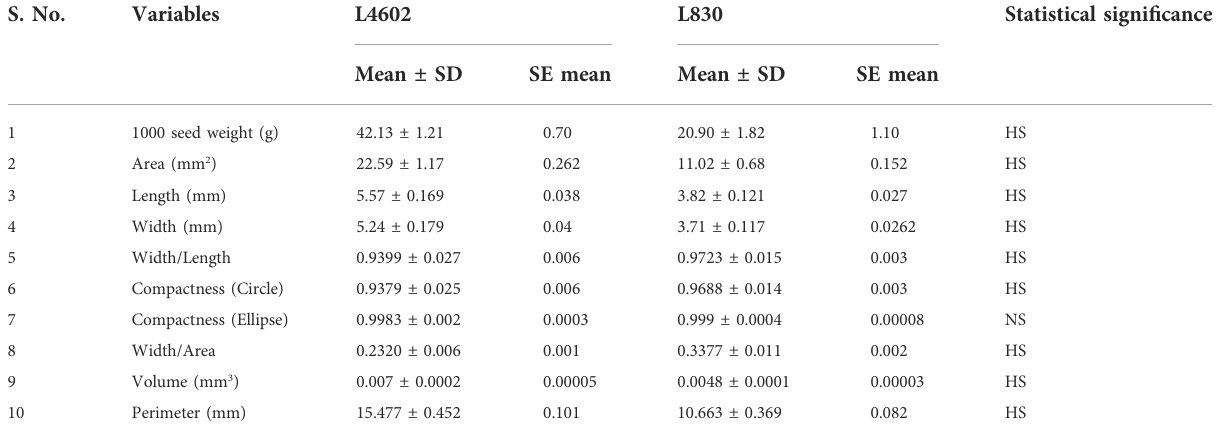
TABLE 1 Descriptive statistics for various seed traits of the genotypes L4602 and L830 using t-test. S.